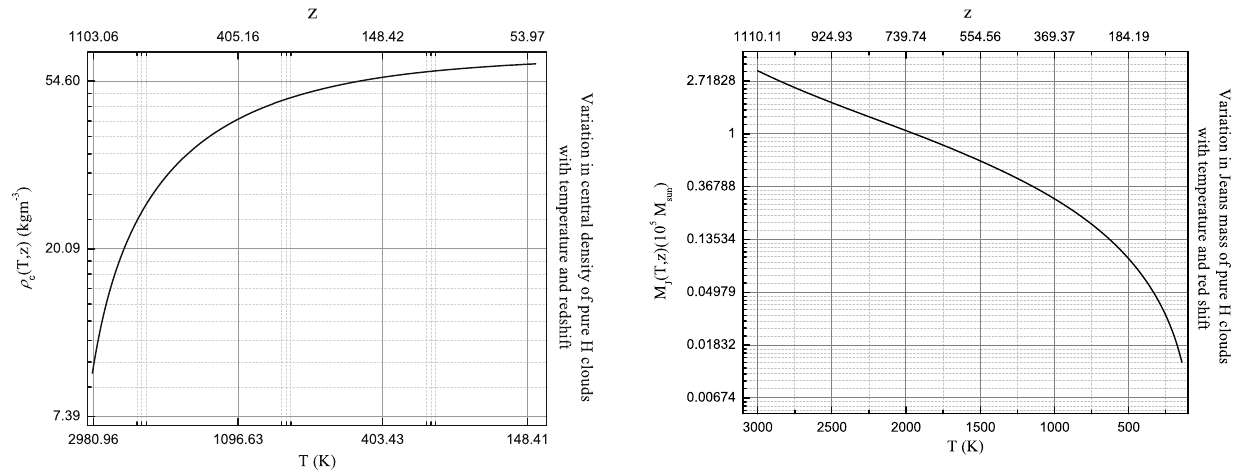
Fig. 2 Variation in the Jeans mass of pure H virial clouds